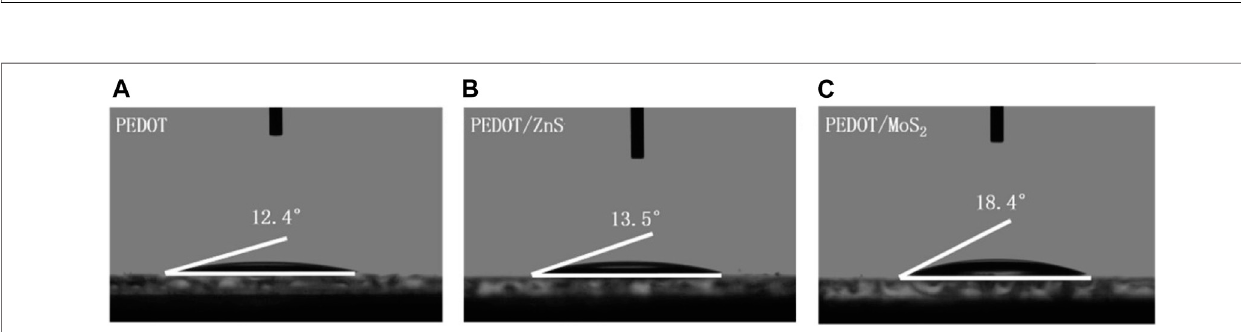
FIGURE 2 | Structure of the green phosphorescent OLEDs with (A) neat PEDOT:PSS HIL and (B) hybrid HIL. (C) The corresponding energy level diagram of the devices.